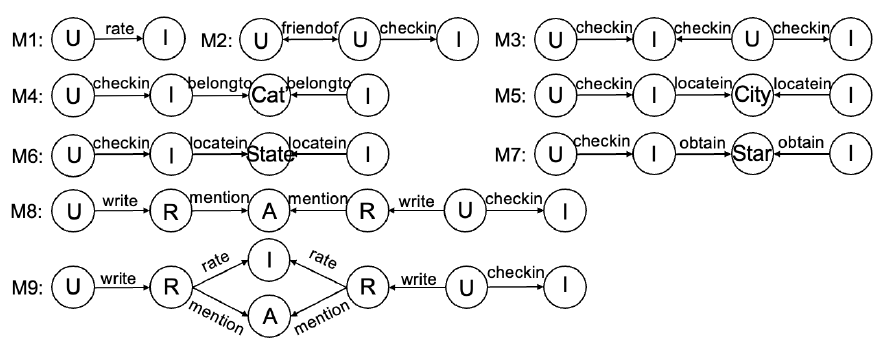
Figure 3. Metagraphs used in Yelp dataset.